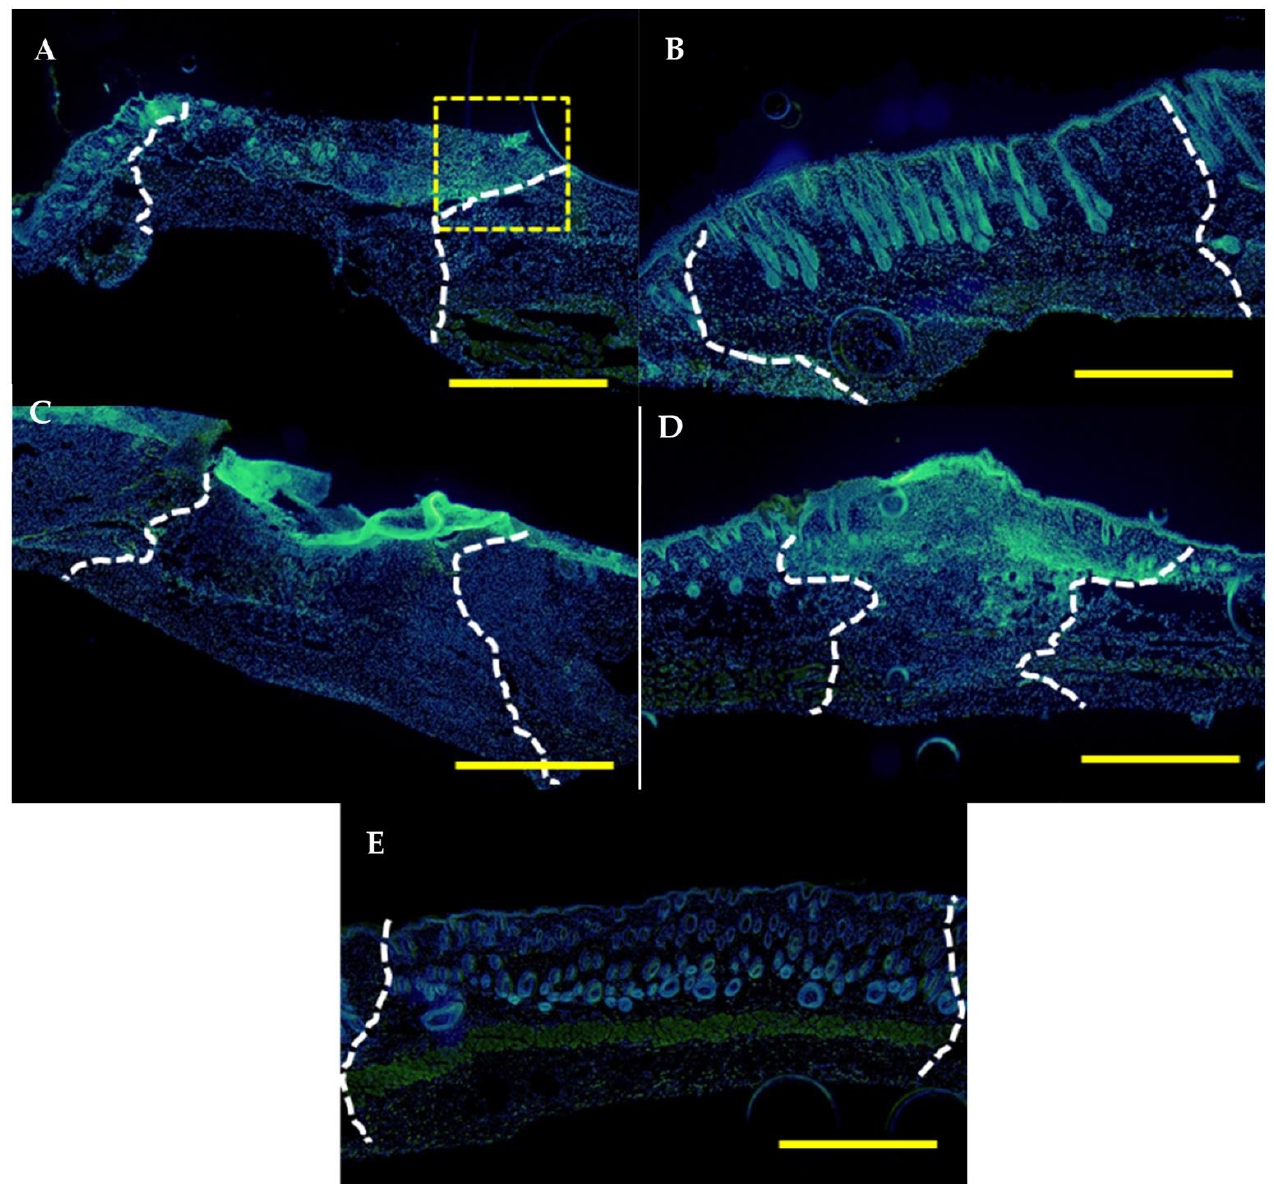
Figure 12. Representative CD68-DAPI immunological image of the harvested tissue on day 7 after treatment with control ( A ), PEG-D4-Si ( B ), PEG-D6-Si ( C ), PEG-D8-Si ( D ), and PEG-D6 ( E ). Yellow dash line box gives the example for the area used to calculate CD68-positive cells. White dash line indicates the wound proximities. Green = CD68-positive cells and blue = cell nucleus. Scale bars are 1 mm.